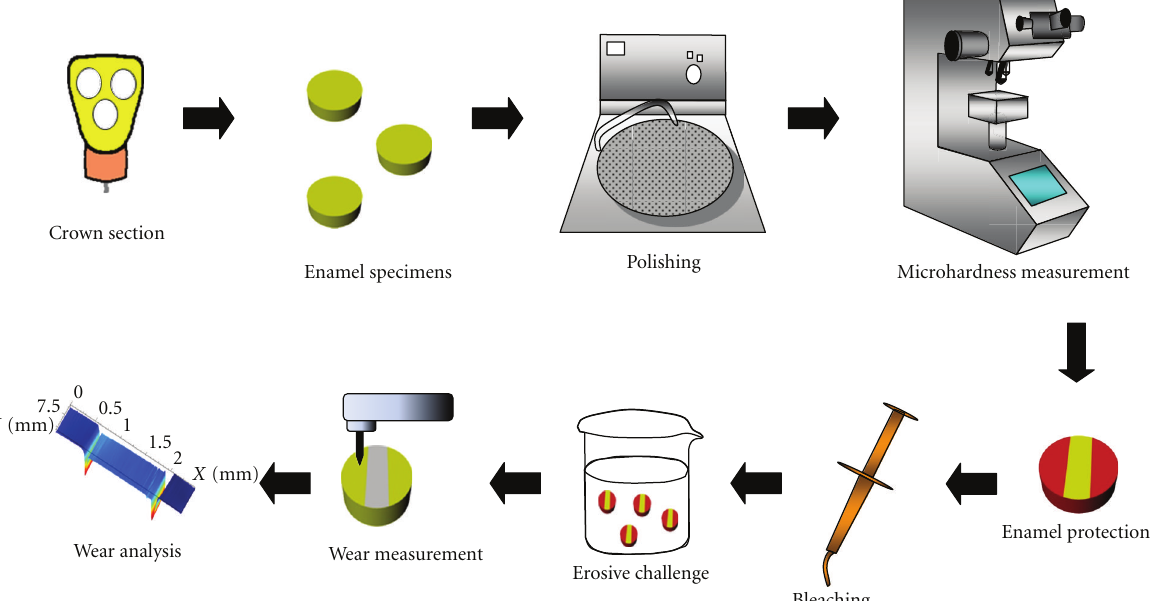
Figure 1: Schematic representation of sample preparation and